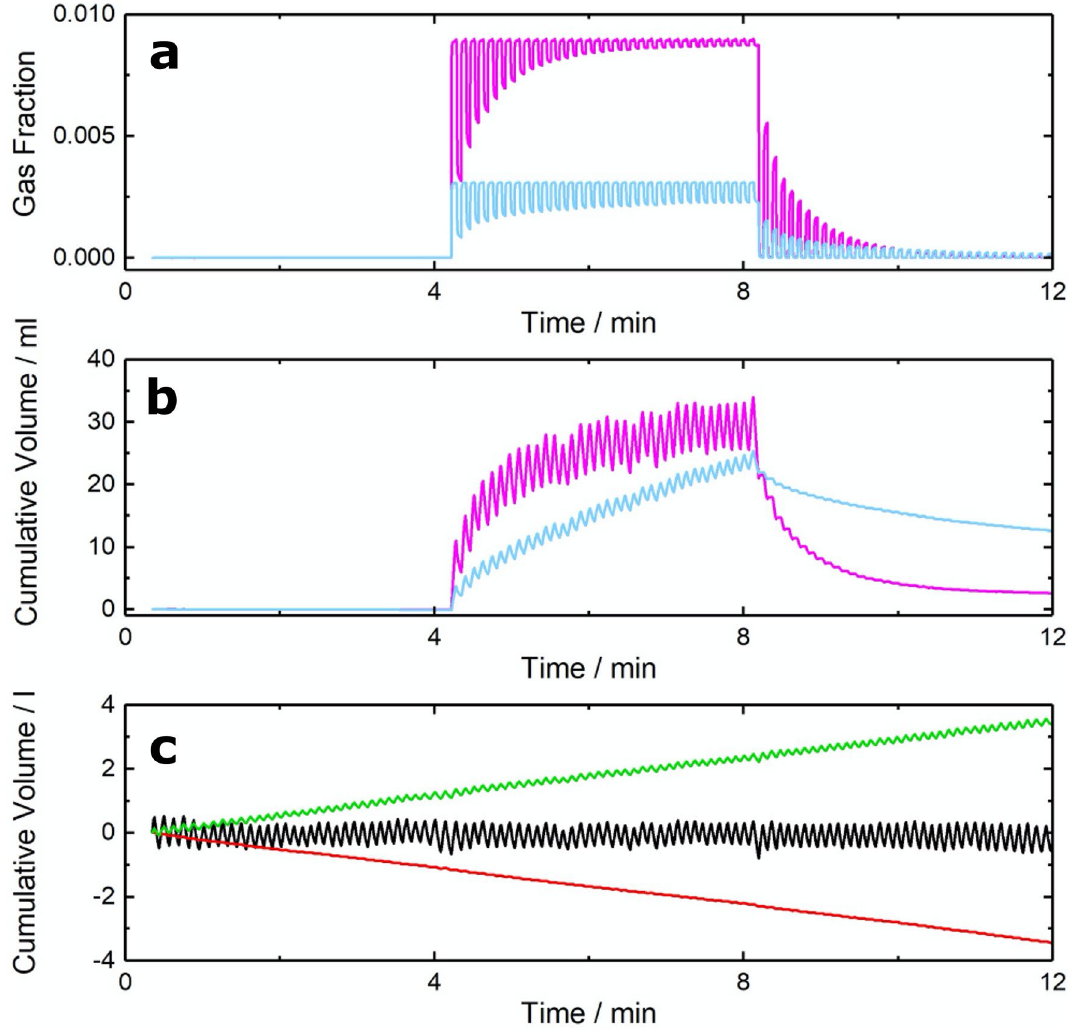
Figure 2. Gas fractions and cumulative gas exchange recorded before, during and after a tracer gas wash-in. ( a ) Gas fractions for methane (magenta) and acetylene (blue). ( b ) Cumulative uptake of methane (magenta) and acetylene (blue). ( c ) Cumulative gas exchange for oxygen (green), nitrogen (black), and carbon dioxide